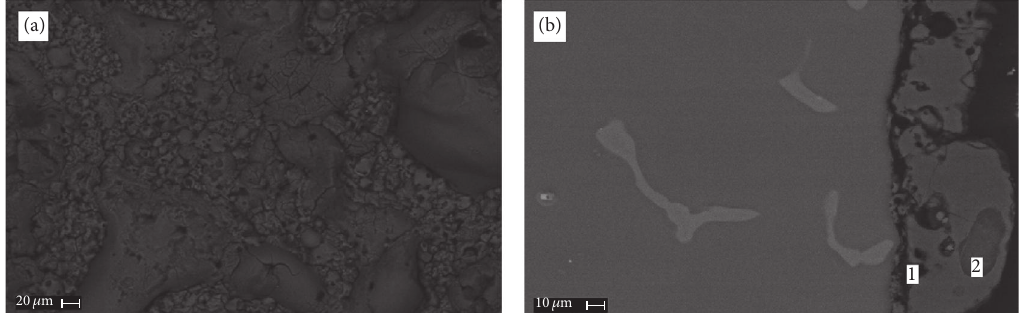
Figure 6: Scanning electron micrographs (backscattered electrons) of the surface and cross section of PEO coating formed on AZ91 magnesium alloy. The sample was treated at 0.5 A/cm 2 for 2 minutes in an aqueous alkaline solution with 50 g/l of Na 2 SiO 3 , 40 g/l of NaOH, and 50g/l of Na 5 P 3 O 10 .